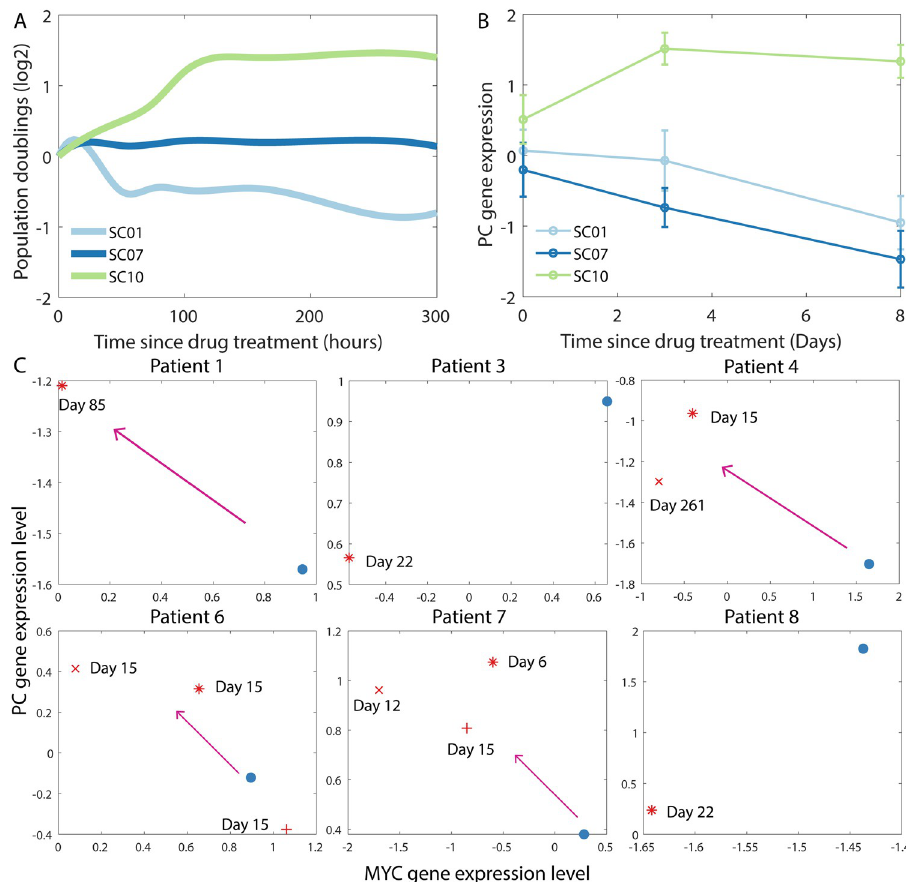
Fig 6. Pyruvate carboxylase (PC) expression levels are altered in melanoma cells in response to BRAF signaling inhibitors. (A) Representative depiction of the response of three different subclones of the SKMEL5 melanoma cell line to treatment with PLX4720, a mutant BRAF inhibitor, as reported by Paudel et al . [52] (see Fig 3A therein). (B) RNA expression levels of the PC gene (Z-score calculated after log 2 normalization) in the three subclones in (A) at 3 days and 8 days post-treatment with PLX4720. The gene expression data was obtained from Jia et al . [53]. The error bars indicate the standard deviation. (C) RNA expression levels of MYC and PC genes (Z-score calculated after log 2 normalization) in tumor samples obtained from melanoma patients. In each panel, the blue dot indicates the expression levels before treatment. The different red markers in each panel indicate the expression levels in samples obtained at different time points after treatment with BRAF signaling inhibitors. The gene expression data was downloaded from the Gene Expression Omnibus databse (accession GSE75299). See Song et al . [54] for details regarding the patient samples and the BRAF signaling inhibitor administered in each case. In panels C and D, the Z- scores were calculated as Z PC ¼ E PC i (cid:0) m PC where E PC is the PC expression level in the i th sample while μ PC and σ PC are the i i s PC mean and standard deviation of the PC expression levels in the dataset,